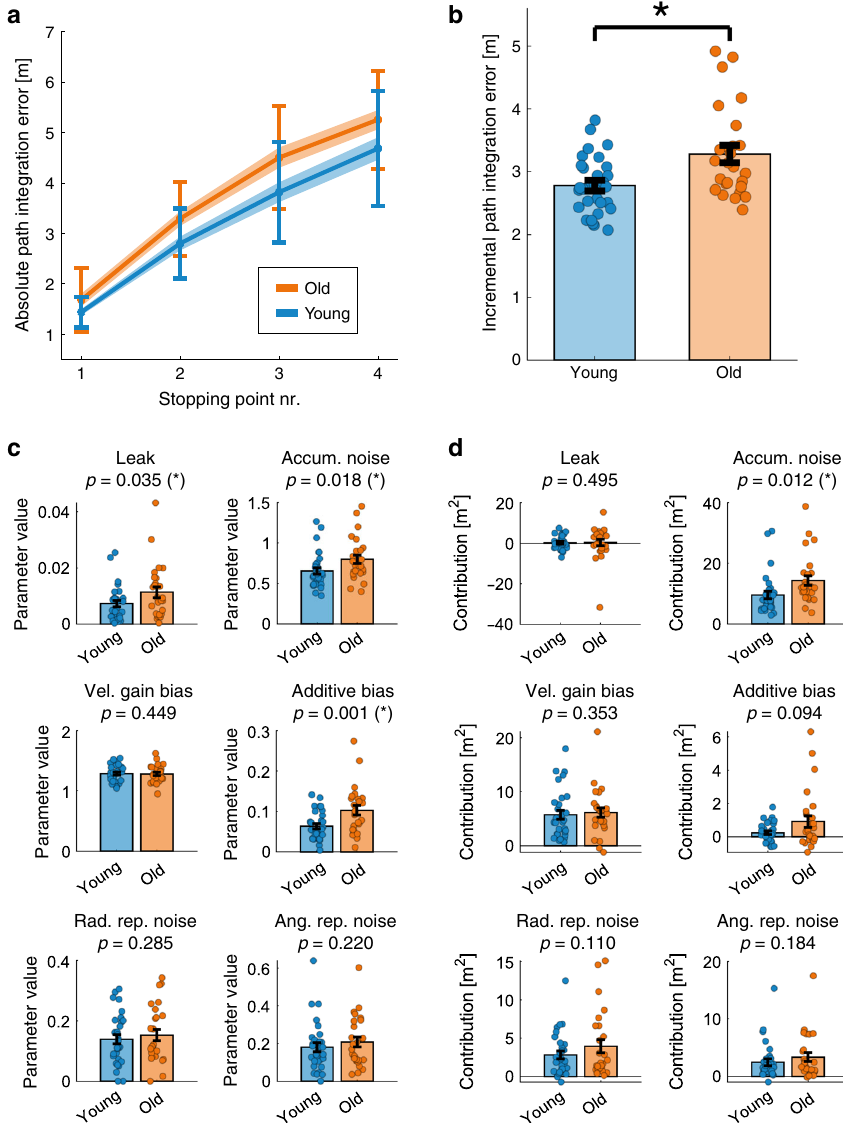
Fig. 5 Path integration in older versus young adults. a On average, older adults showed a higher absolute path integration error than young adults at all stopping points. Blue and orange shaded lines indicate group mean ± SEM, error bars indicate SD. b The incremental path integration error (i.e., the additional contribution to the path integration error for each segment between adjacent stopping points), averaged across stopping points, was higher for older than young adults ( p = 0.001). c Model parameter values, averaged over participants of the same age group. Parameter values for leak, accumulating unbiased noise, and additive bias were signi fi cantly higher in older relative to young adults. Individual parameter values for single participants are shown in Supplementary Fig. 1. d Each model parameter ’ s contribution to the absolute square error, averaged over participants of the same age group. Only the accumulating unbiased noise resulted in a signi fi cant difference in error contribution between age groups. A parameter ’ s contribution is calculated by measuring the reduction in square error when setting the parameter to its ideal value corresponding to unbiased, noiseless integration; note that due to the non-linearity of the model a parameter's contribution can be negative (see “ Methods ” section for more details). Dots indicate data for individual participants. Error bars in panels b – d indicate mean ± SEM ( n = 30 young vs. 26 older participants). * Denotes a signi fi cant difference between age groups ( p < 0.05) in a one-sided permutation test with 10,000 causes the largest increase in model fi t (Fig. 3d). Intuitively, adults. Absolute path integration errors were signi fi cantly higher in Fig. 3d can be interpreted as a measure of “ error shape ” , namely older adults by the fi rst stopping point, and continued to be higher how different sources of error grow with traveled distance and at all subsequent stopping points along the path (Fig. 5a; stopping distance to the starting point, while Fig. 3e measures “ error size ” point #1: p = 0.016; #2: p = 0.004; #3: p = 0.005; #4: p = 0.005). in the context of the full model. In models without reporting Moreover, incremental path integration errors or the gain in error noise, all errors have to be fi t by a single noise source of incorrect between adjacent stopping points (pooled over all stopping points; shape, which causes the large discrepancy in Fig. 3d. see “ Methods ” section for more details) were signi fi cantly higher for older relative to young adults (Fig. 5b; p = 0.001). In order to test whether the age effect in path integration Age-related differences in path integration . Older adults per- performance might be driven only by a few particularly high or formed less well in the path integration task compared to young